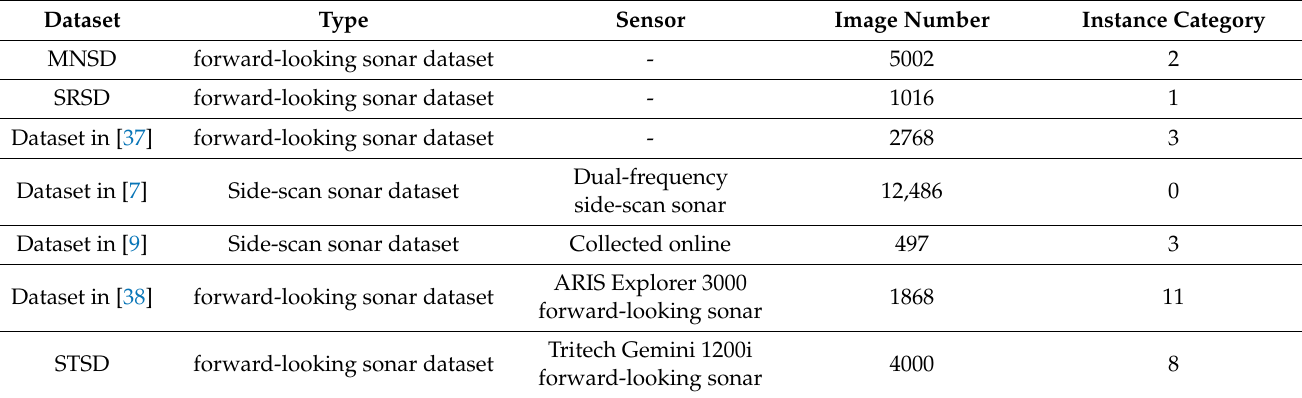
Table 1. Comparison of several sonar